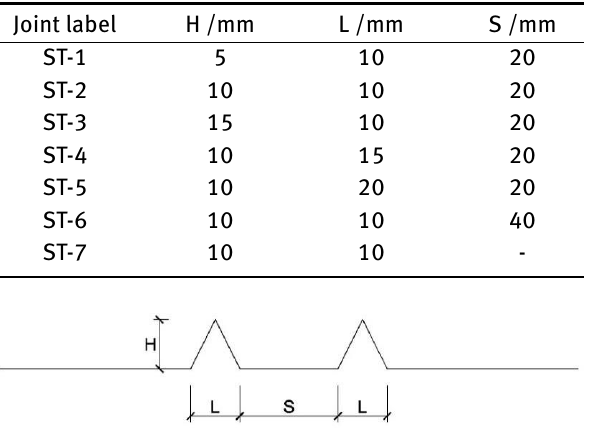
Figure 5: Schematic diagram of double saw-tooth rock joint